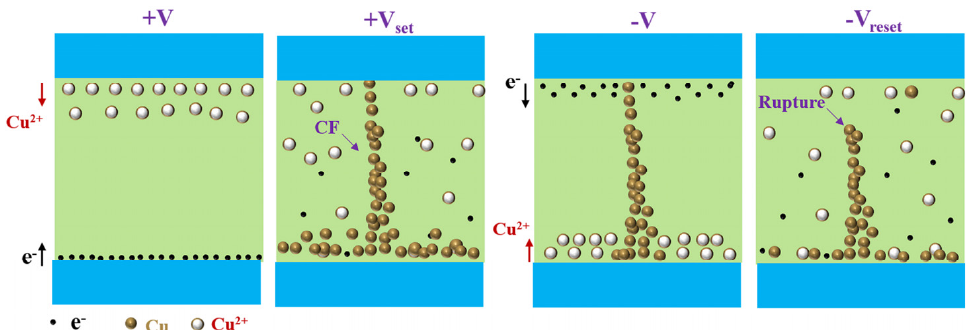
Figure 5. Schematic formation mechanism of the bipolar RS characteristic of the Cu/Al 2 O 3 /Cu de- vices.